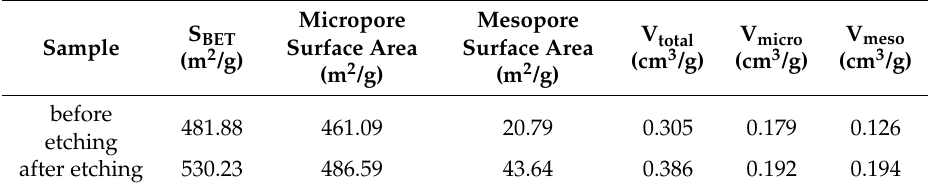
Table 2. Surface and porous parameters of Si/MC